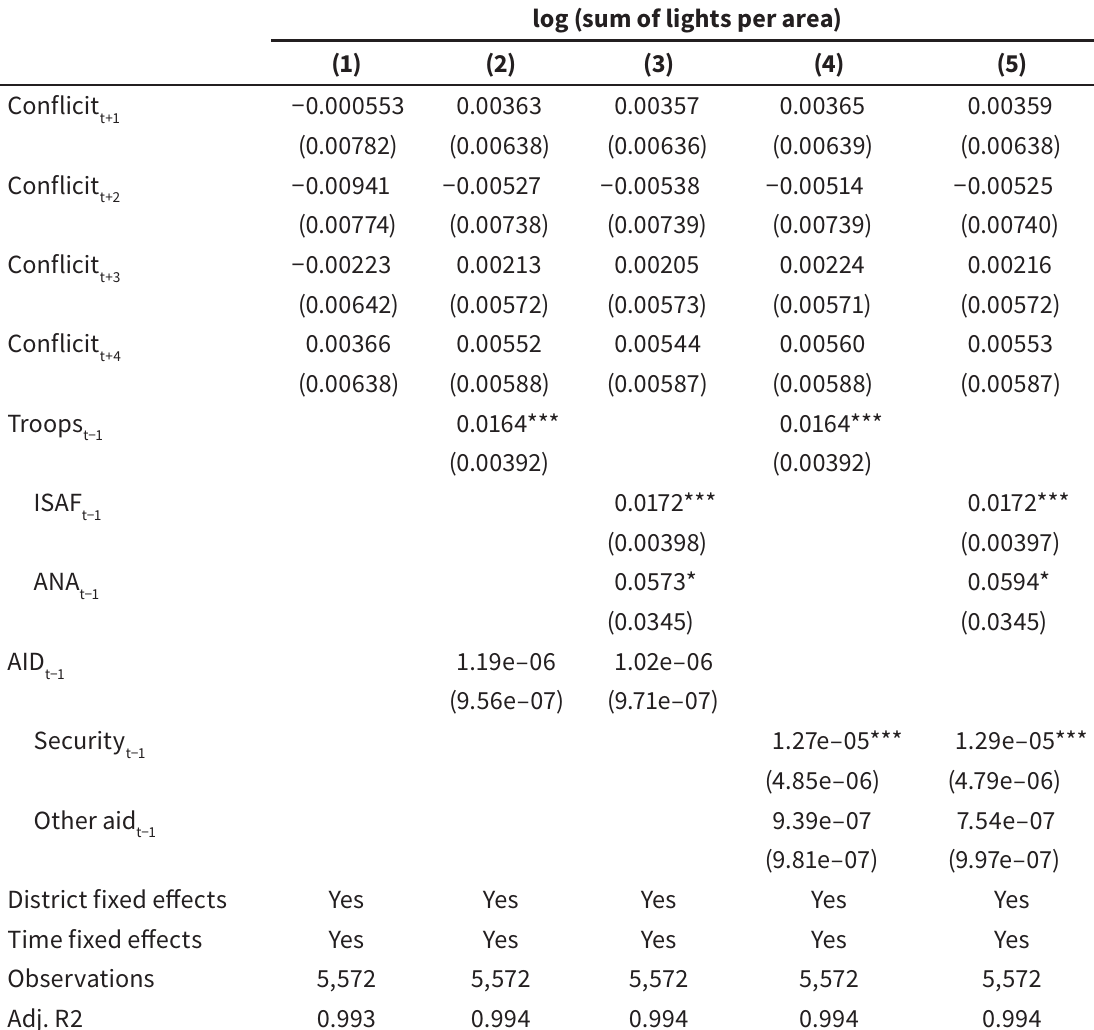
Conflict and nighttime light (placebo